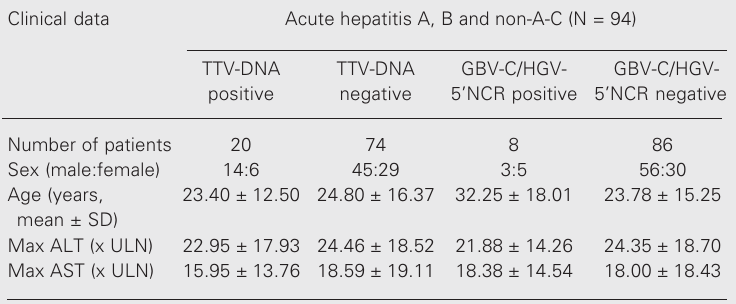
Table 3. Comparison of acute hepatitis patients with and without serum TTV-DNA or